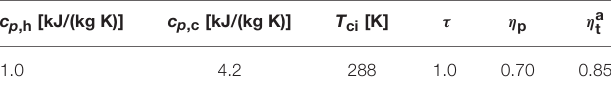
TABLE 3 | Fixed parameters for the optimization case